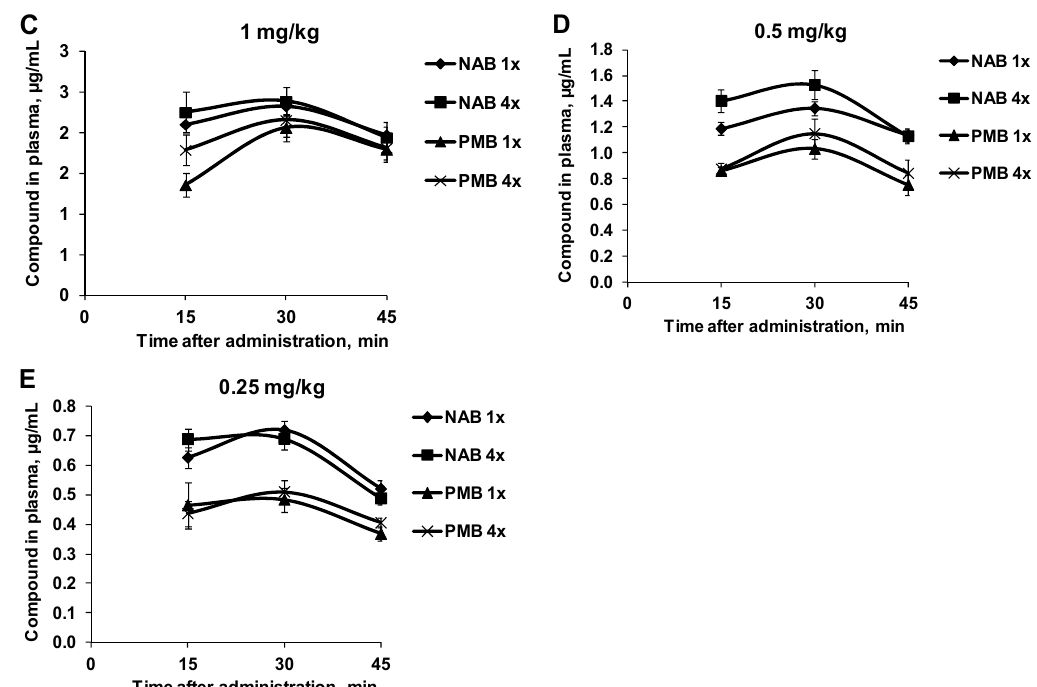
Figure 3. Comparison of PK profiles in NMRI mice plasma after the first and the last SC administration of NAB739 and PMB at doses of 4 ( A ), 2 ( B ), 1 ( C ), 0.5 ( D ), 0.25 ( E ) mg/kg. Data expressed as average ± SEM from four mice.